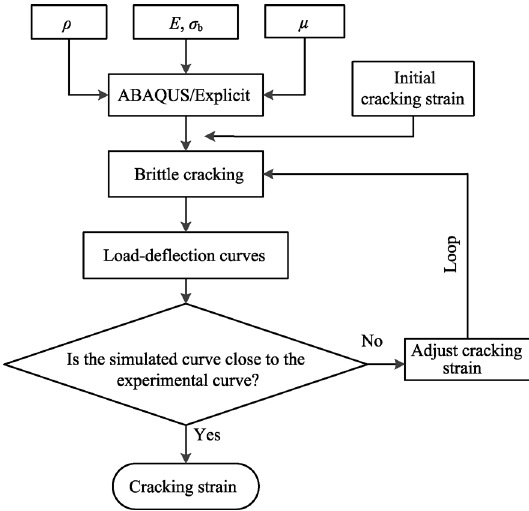
Fig. 7 Estimation procedures of the cracking strain of freestanding GYbZ coating sample by using